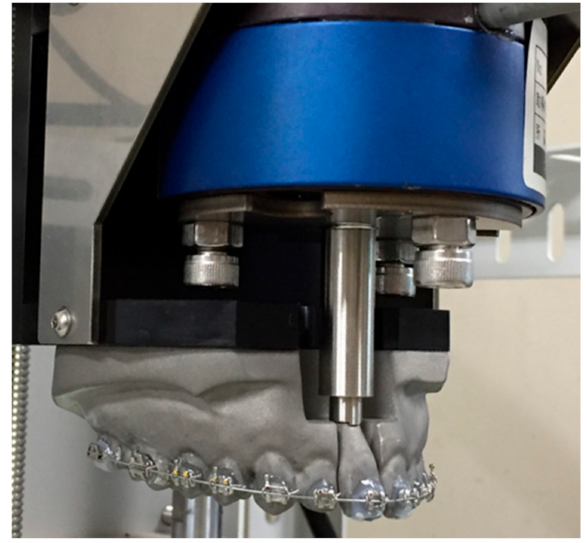
Figure 3. A multi-bracket orthodontic appliance